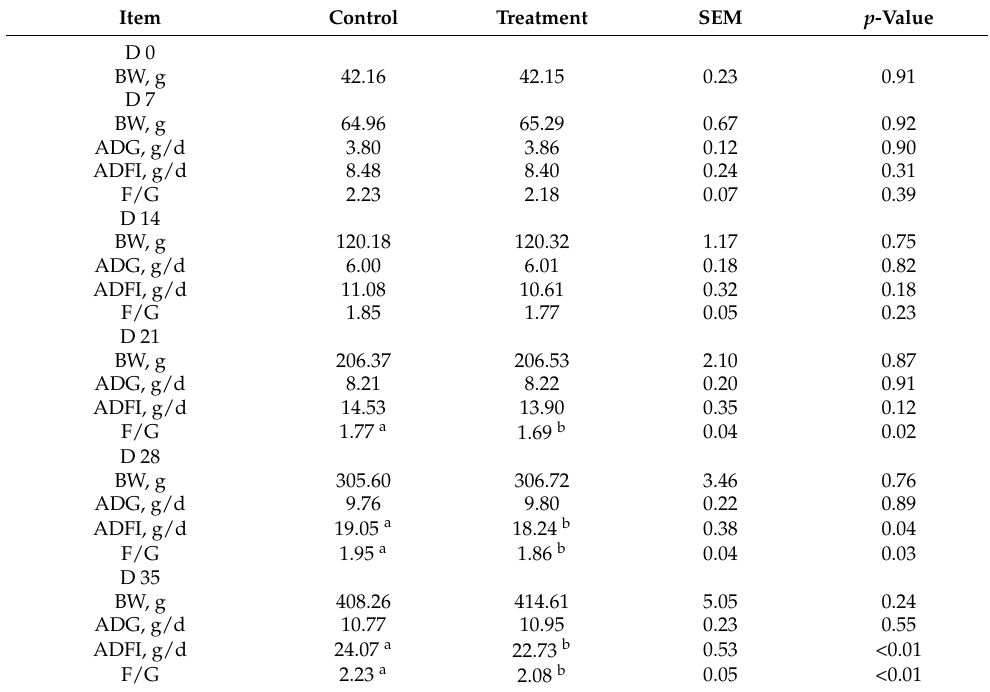
Table 3. Effects of two supplementary doses of vitamin A on performance of young laying pullets 1 .